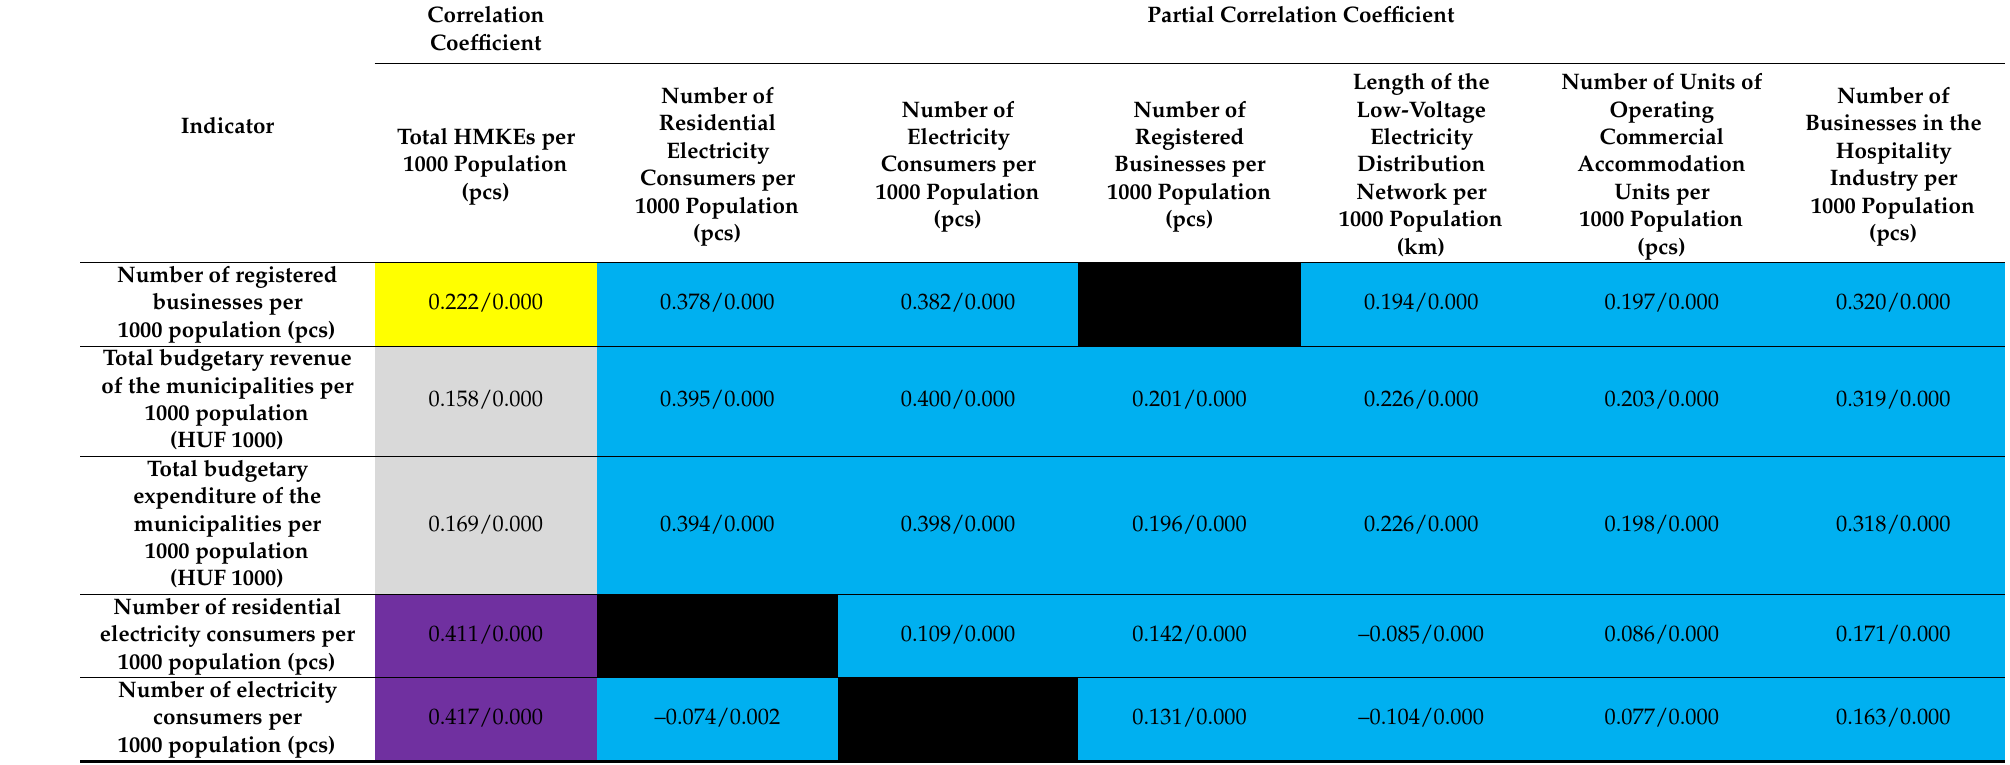
Table 5. The strength of the relationship between the quantity of the total HMKEs per 1000 population and the settlement indicators 1 ( 1 Pearson correlation coefficient/ p -value; if p < 0.05, then there is a significant verified relationship between the two variables) (In the case of the Pearson correlation coefficients in the table grey background indicates weak correlations, yellow means weak moderate, and purple moderately close ones. In the case of the partial correlation the blue background signals partial explanation (the controlled variable explains the relationship between variables i and j only partially), while the black one shows irrelevant